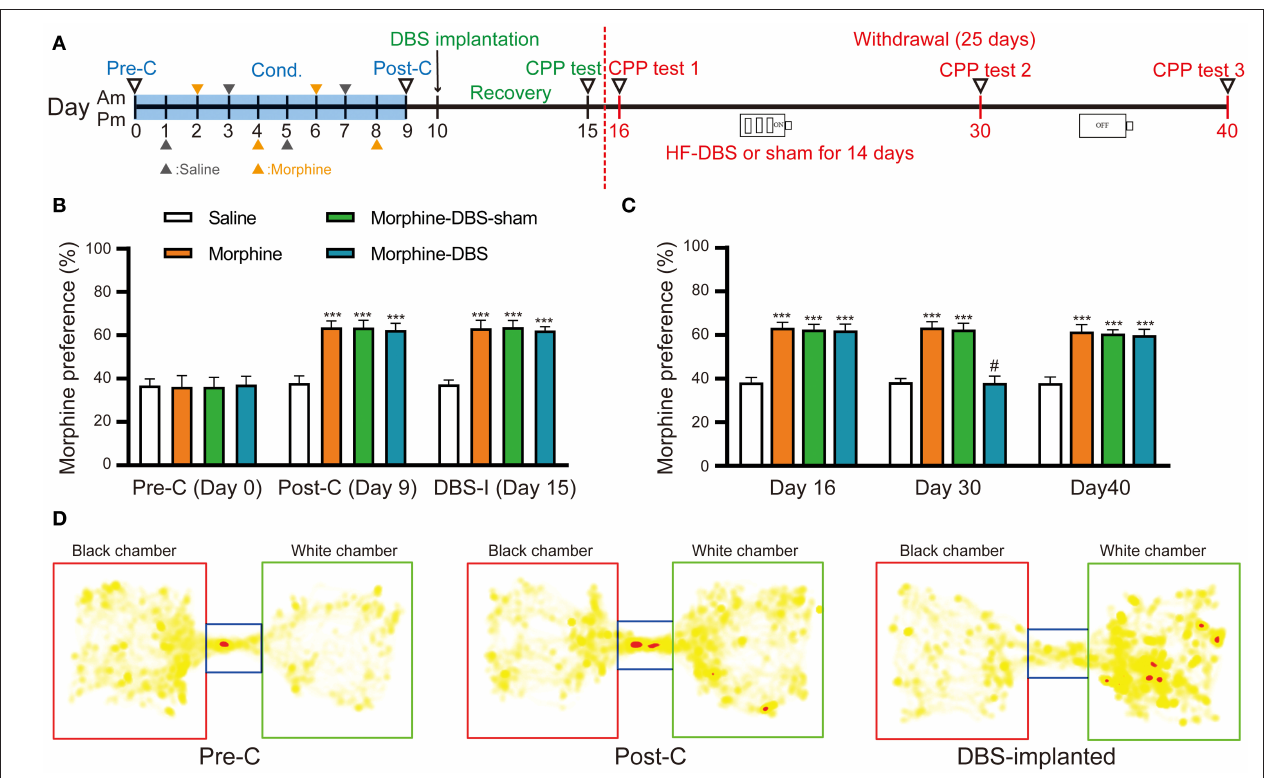
FIGURE 2 | Continuous high frequency-DBS (HF-DBS) of anterior insular (AI) suppresses morphine-induced conditioned place preference (CPP). (A) Experimental timeline. The morphine CPP protocol starts with a pre-conditioning test (Day 0, pre-C) followed an 8-day conditioning (i.p. 10 mg/kg morphine or 0.9% saline on alternating days) and a post-conditioning test (Day 9, post-C). Once the morphine CPP was successfully established, the rats were bilaterally implanted with DBS electrodes to AI (Day 10) followed by a 5-day recovery and a CPP test was performed (Day 15, DBS-I). The rats further underwent morphine abstinence for 25 days. HF-DBS (130Hz, 150 µ A, 90 µ s) was continuously applied for the first 14 days (Day 16–30) and CPP tests were performed (Day 16, 30, and 40). (B) The 8-day morphine conditioning induced significantly higher morphine preferences than the saline control group (Bonferroni’s post hoc test, day 9, post-C, *** p < 0.001 vs. saline control) [phase: F (4, 47) = 332.771, p < 0.001; group: F (3, 50) = 323.751, p < 0.001; interaction: F (12, 147) = 20.674, p < 0.001]. Morphine elicited significant side preference in electrodes-implanted rats and the morphine-induced CPP persisted 5-day after the implantation of DBS electrodes (Bonferroni’s post hoc test, day 15, *** p < 0.001 vs. saline control). (C) Continuous HF-DBS (Day 16–30) reduced morphine-induced CPP on day 30 as compared with the morphine-DBS sham group (Bonferroni’s post hoc test, day 30, *** p < 0.001 vs. saline group, # p < 0.001 vs. morphine- and morphine-sham-DBS). The morphine-induced CPP